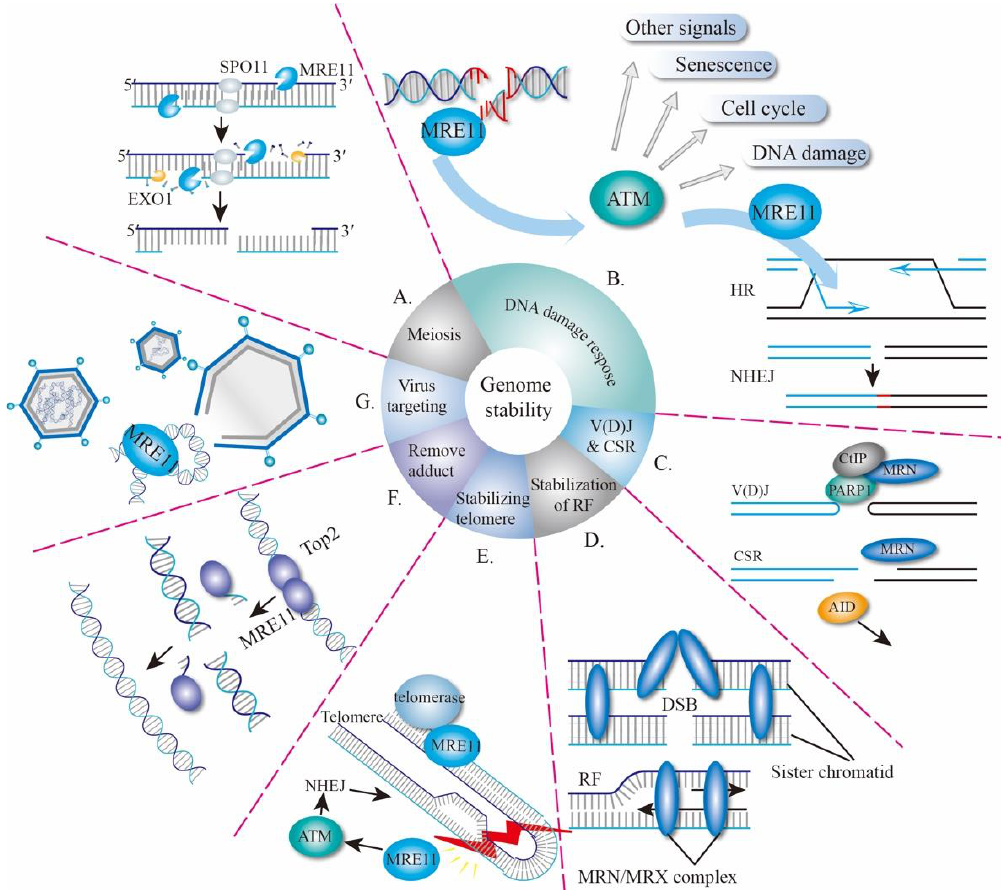
Figure 1. Biological Functions of MRE11. ( A ) MRE11 is involved in meiosis to remove Spo11 with endonuclease activity. ( B ) MRE11 is involved in whole DNA damage response, including DSB recognition, signaling and repair. ( C ) CSR and V(D)J recombination. ( D ) Stabilization of replication forks. ( E ) Stabilizing telomere. ( F ) Removal of toxic DNA adduct. ( G ) Virus targeting. CSR, class switch recombination; V(D)J, V (variable), D (diversity), J (joining) genes; RF, replication fork; HR, homologous repair; NHEJ, non-homologous end-joining; DSB, DNA double-stranded